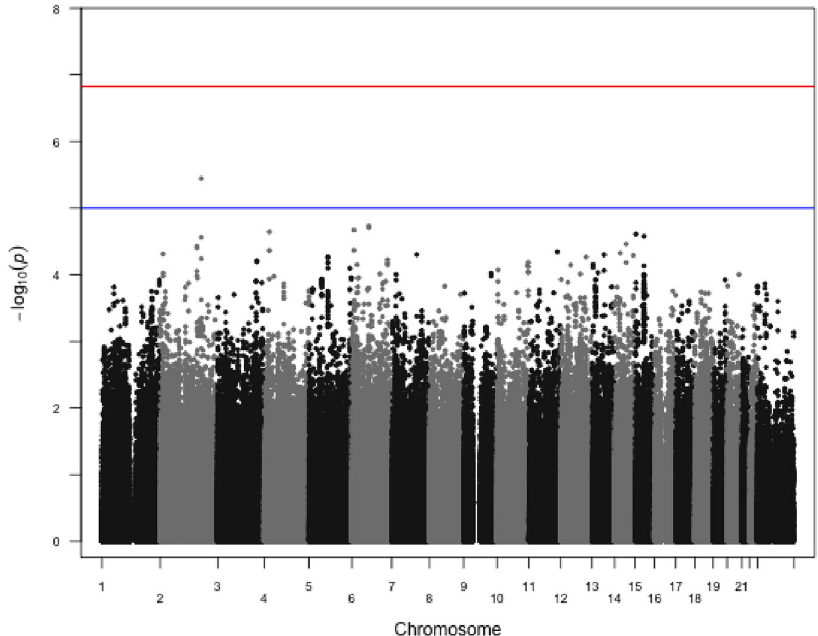
Fig. 2 Manhattan plot of associations between SNPs and HER2 status. Association testing has been carried out using the additive model and logistic regression using the ProbABEL function. Models were corrected for the fi rst two principal components and age at diagnosis. The blue horizontal line represents the arbitrary 1.0 × 10 − 5 threshold, while the red horizontal line corresponds to the empiric threshold of 1.48 × 10 − 7 as calculated using simpleM followed by Bonferroni